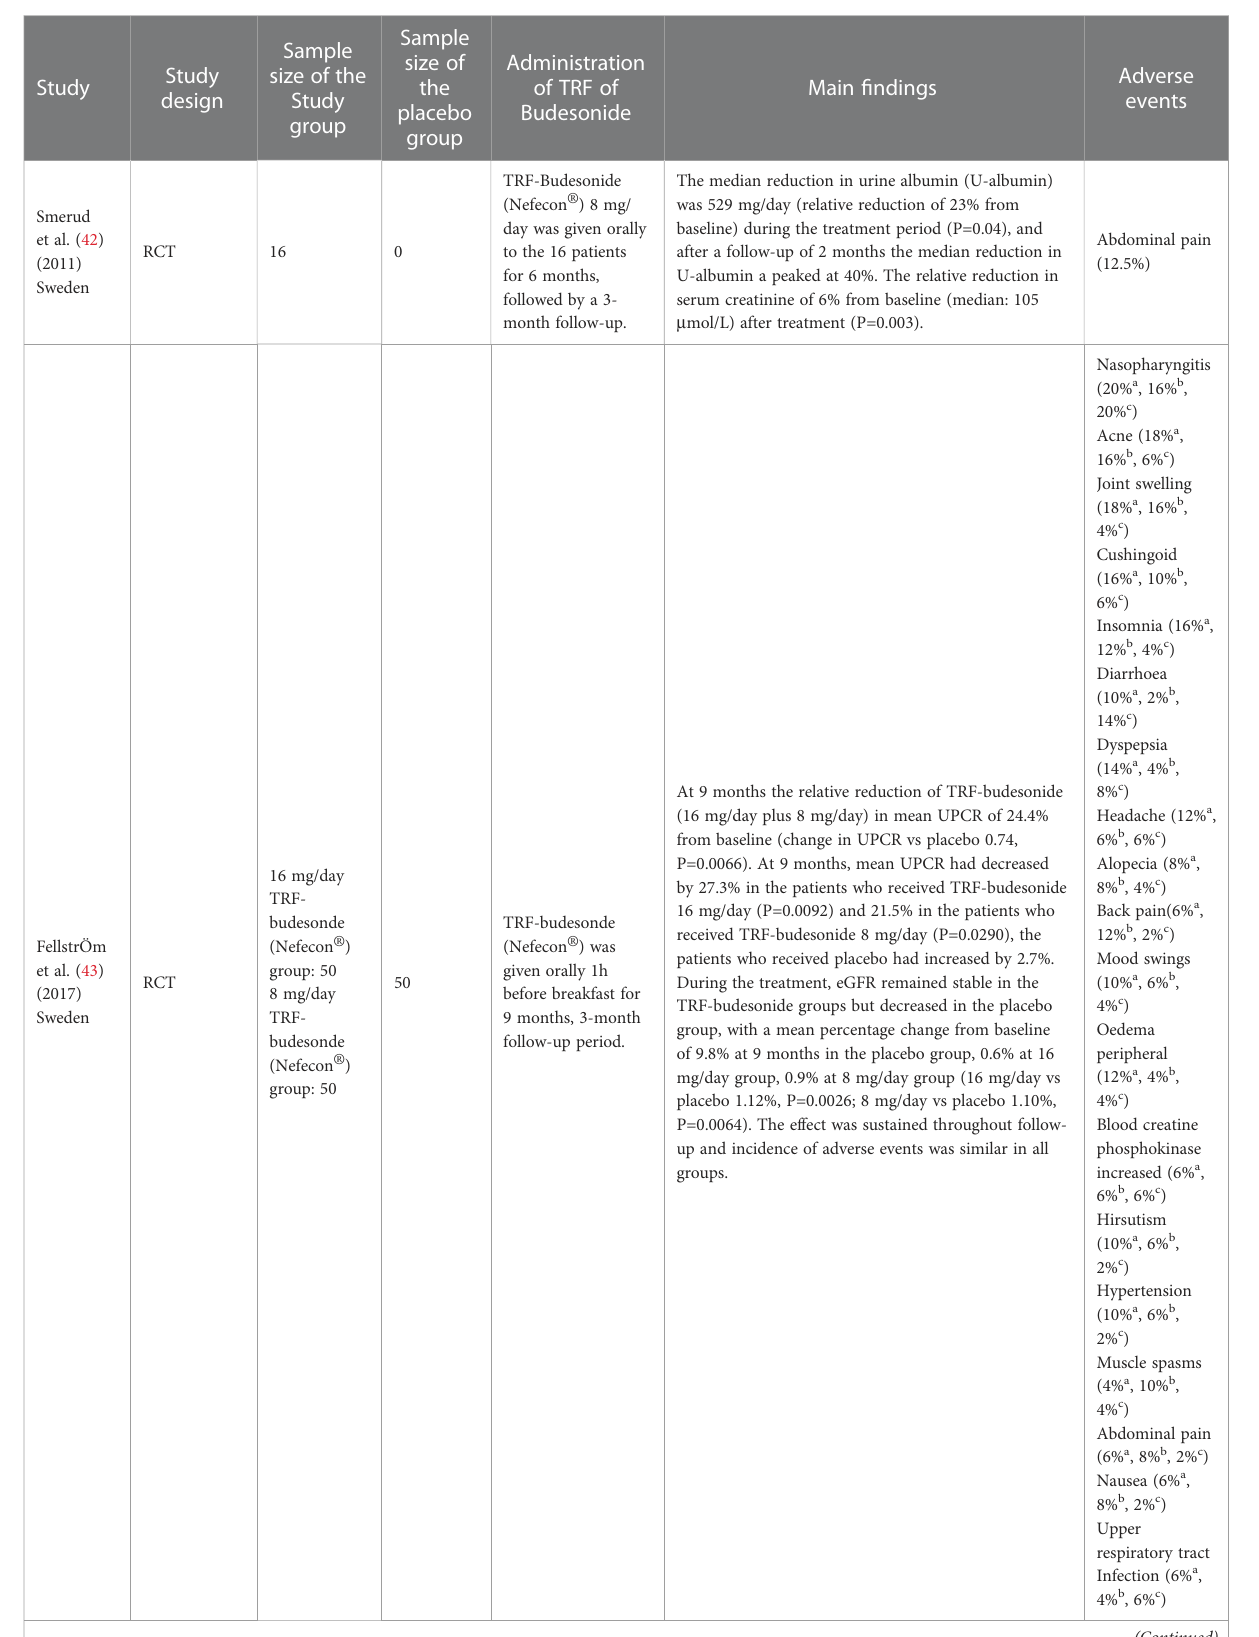
TABLE 1 Characteristics and the main fi ndings in the six included